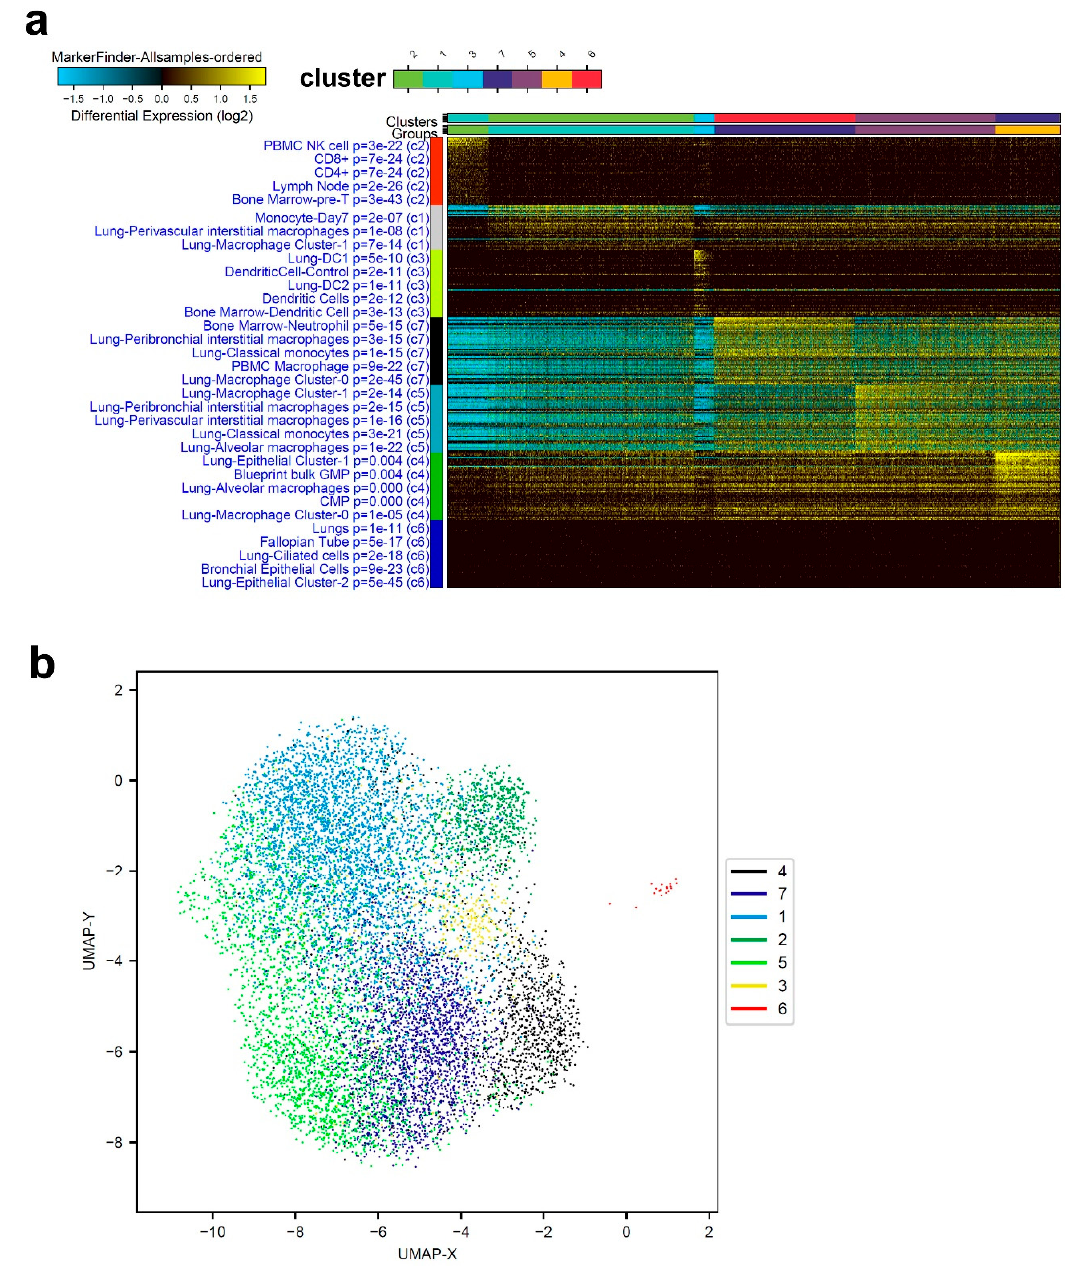
Figure 1. Representative single-cell analysis of bronchoalveolar lavage (BAL) from healthy subjects. ( a ) Representative single-cell analysis of BAL from healthy subjects employing the iterative clustering and guide-gene selection 2 (ICGS2) algorithm depicted as heat map. The text on the left indicates enriched cell-type markers from the default gene-set enrichment analysis and corresponding “Z” score p value. ( b ) Uniform manifold approximation and projection (UMAP) dimensionality reduction visualization of cell clusters corresponding to data presented in panel a.